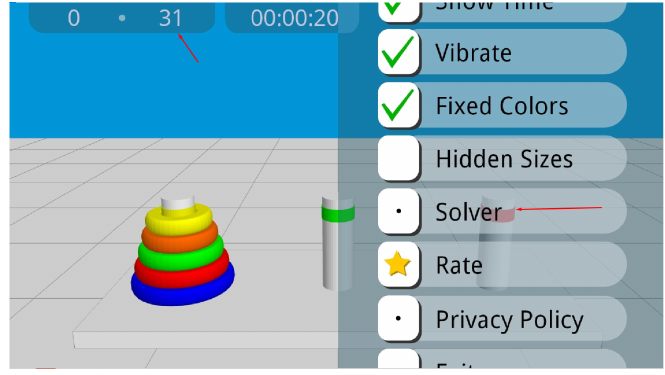
Figure A1. TOH5–Solver.